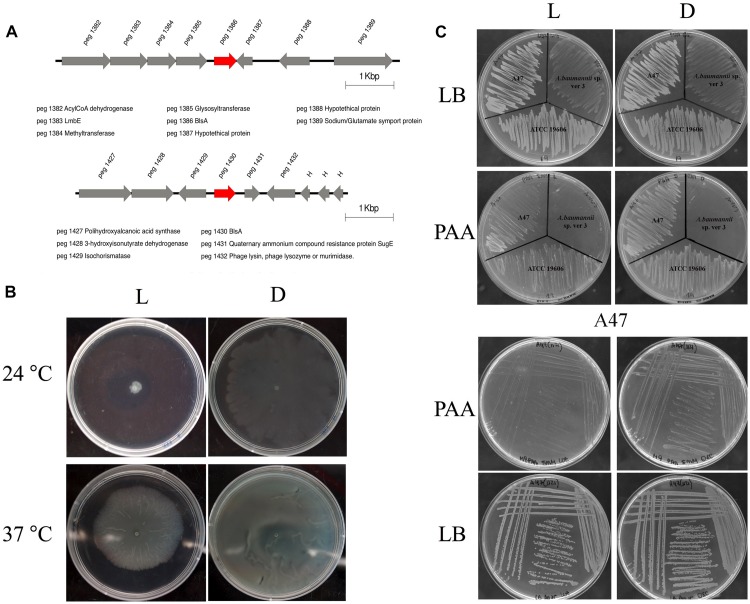
(A) Genomic context of BLUF-domain containing genes in Acinetobacter sp. A47. Gene annotations are indicated below the scheme. In red are indicated BLUF photoreceptors. The figure was constructed using information retrieved from RAST and the seed viewer. (B) Effects of light and temperature on motility. Cells of Acinetobacter sp. A47 were inoculated on the surface of motility plates. Plates were inspected and photographed after overnight incubation in darkness (D) or in the presence of blue light (L) at 24°C or 37°C. (C) Light inhibits growth of Acinetobacter sp. A47 in PAA. Growth of Acinetobacter sp. A47 in M9 minimal agar medium supplemented with 5 mM PAA as a sole carbon source and incubated stagnantly at 24°C under blue light or in the dark. Also shown is growth of A. baumannii ATCC 19606 and Acinetobacter sp. ver 3 as controls, as well as growth in LB to show no effect of light on viability of the strains. Shown are representative results obtained from three independent experiments.